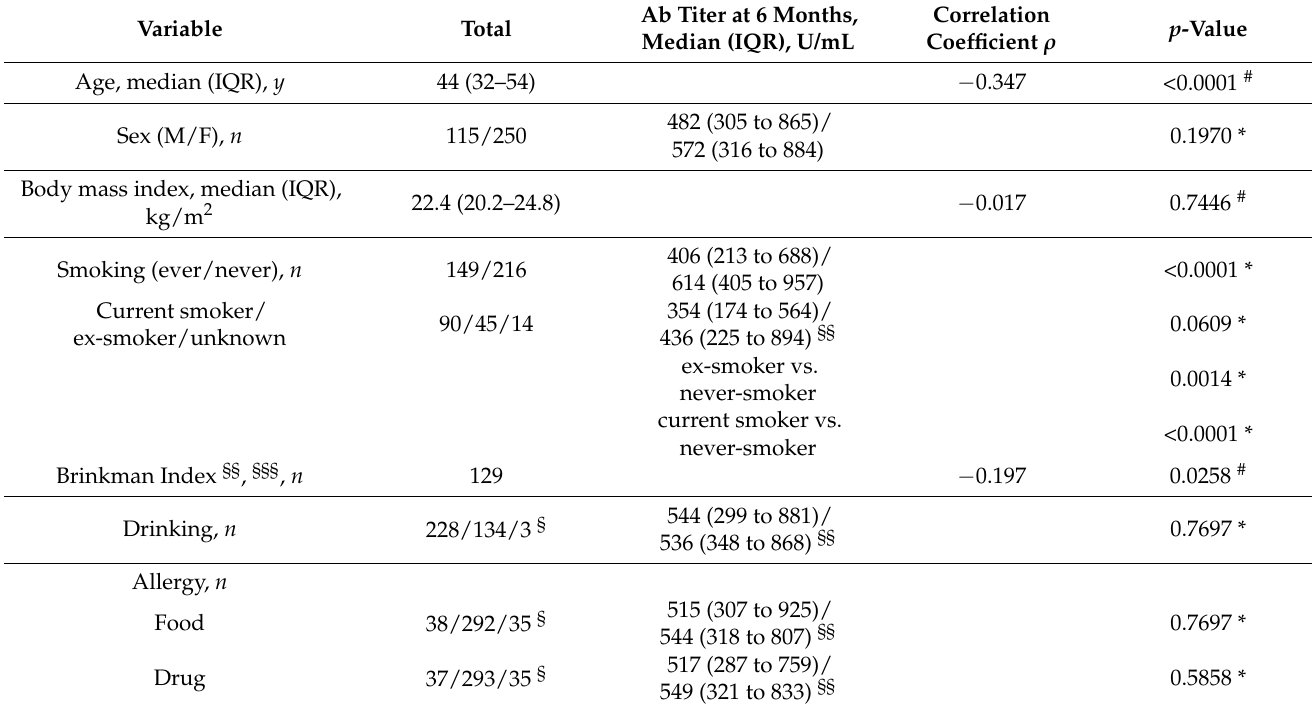
Table 1. Participants’ baseline characteristics ( N =